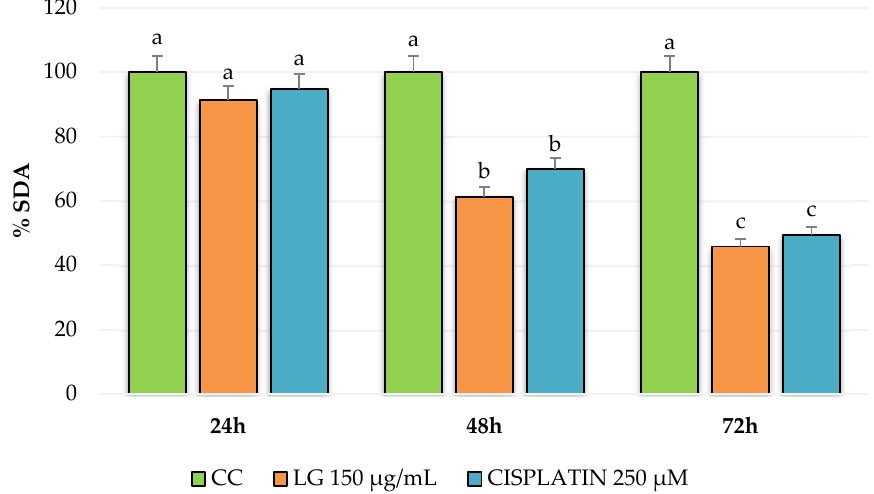
Figure 3. Antiproliferative potential of PRE of L. graveolens on MDA-MB-231 breast cancer cells expressed as a percentage of succinate dehydrogenase activity (%SDA). Values with different letters are statistically different ( p ≤ 0.05). The results are expressed as means (n = 3) ± standard deviation (bars).